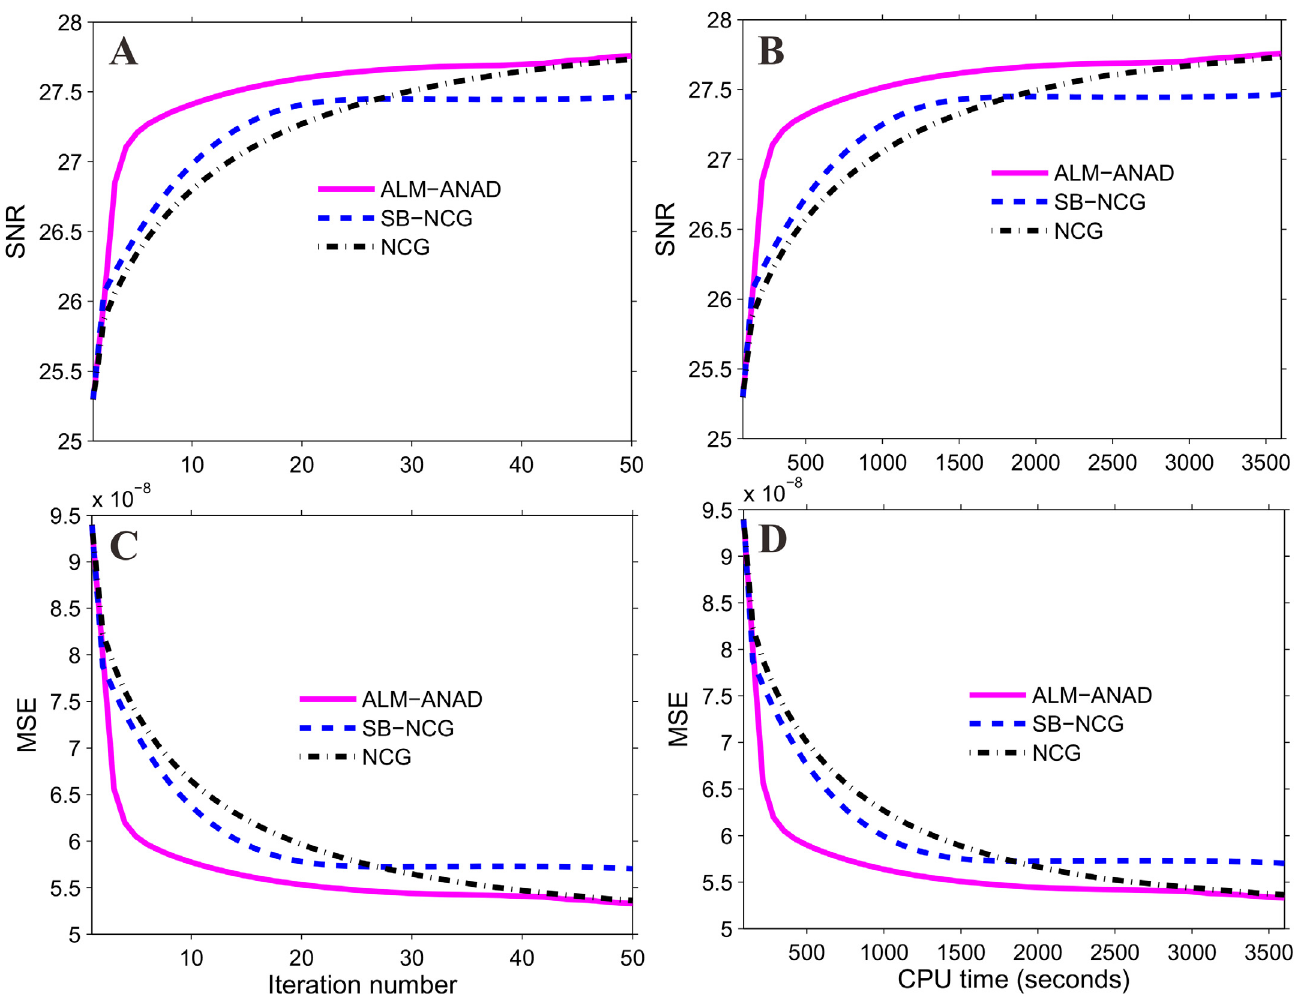
Fig 2. SNR and MSE measurements of three algorithms vs iteration number and CPU time, respectively. (A) is the SNR measures vs iteration number; (B) is the MSE measures vs iteration number; (C) is the SNR measures vs CPU time; and (D) is the MSE measures vs CPU